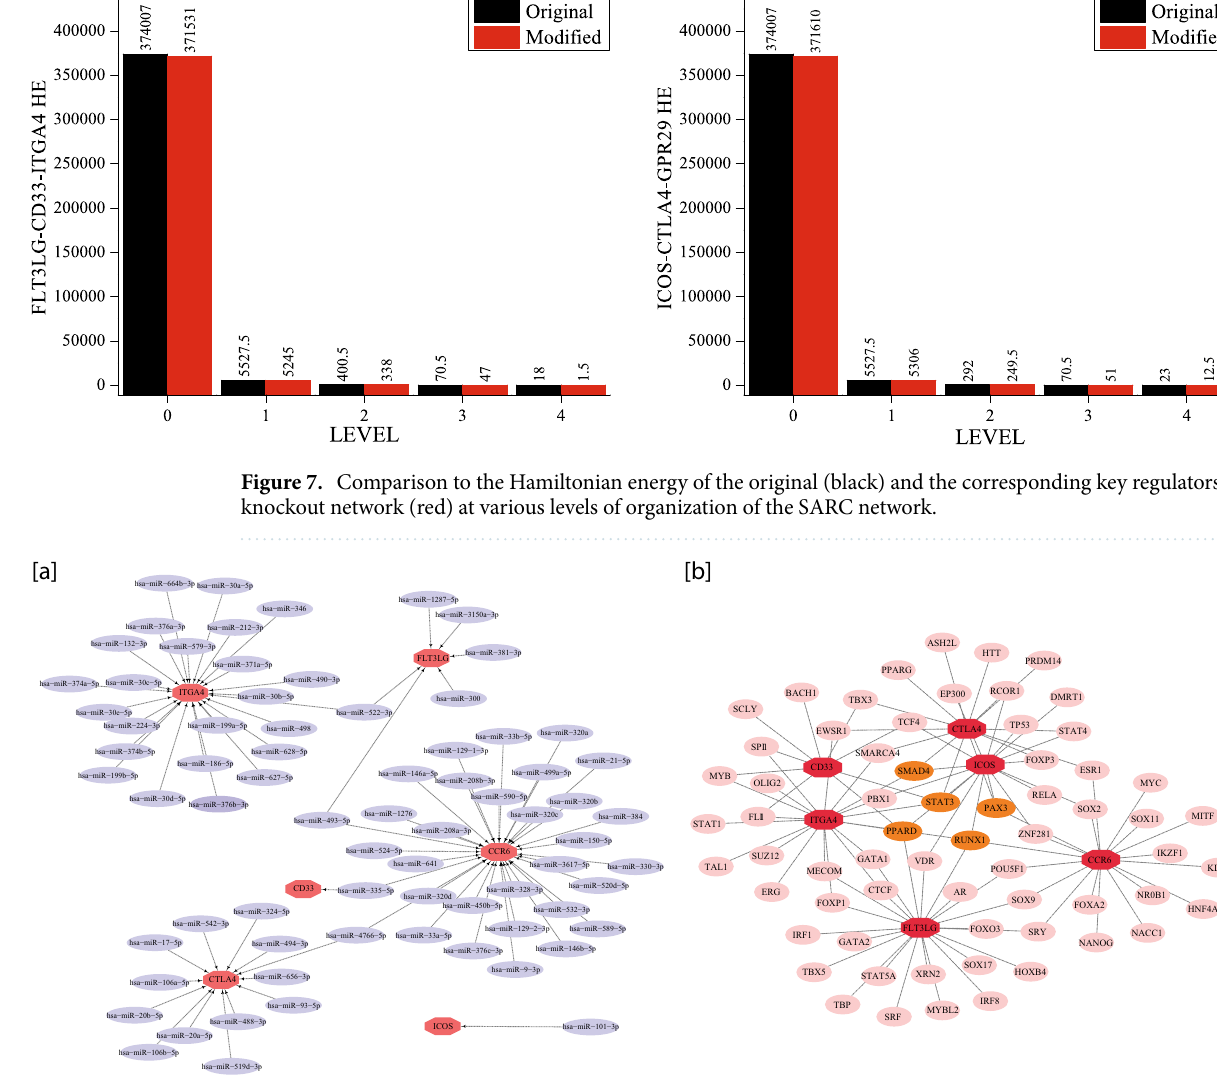
Figure 8. ( a ) Interaction network between key regulators and targeted miRNAs. Orange octagon presented the key regulators and purple circle presented the targeted miRNA. ( b ) The key regulators-transcription factor (TF) regulatory network. Red octagon presented the key regulators, while transcription factors are presented in a pink circle, and highest connection TF is presented in orange